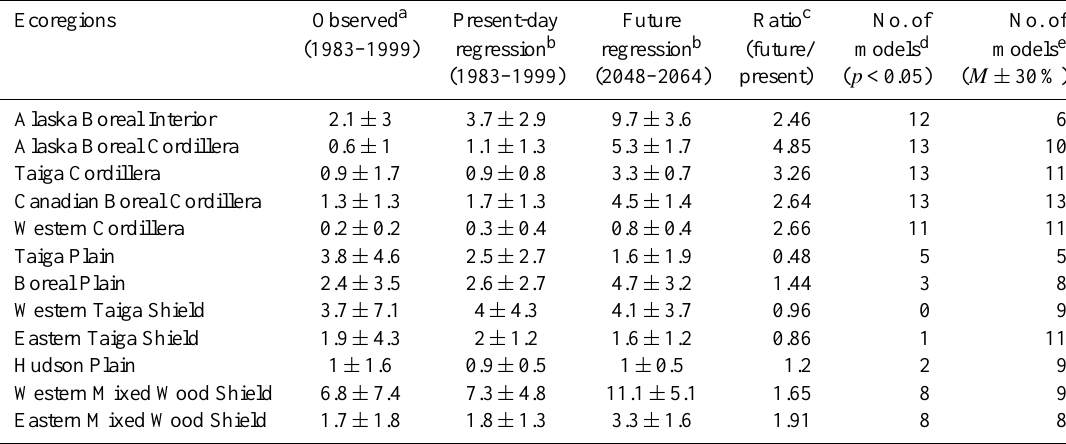
Table 3. Observed and projected area burned in boreal ecoregions.